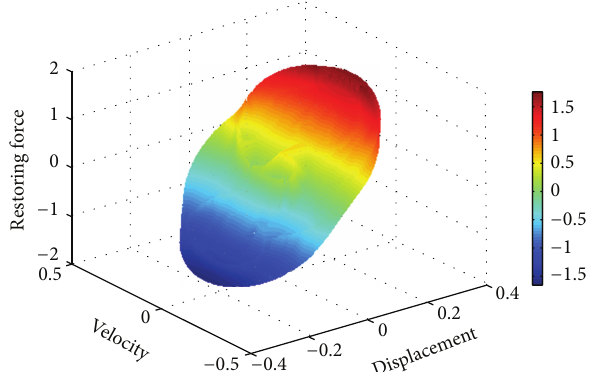
Figure 11: For Example 3, restoring force surface based on GPS.